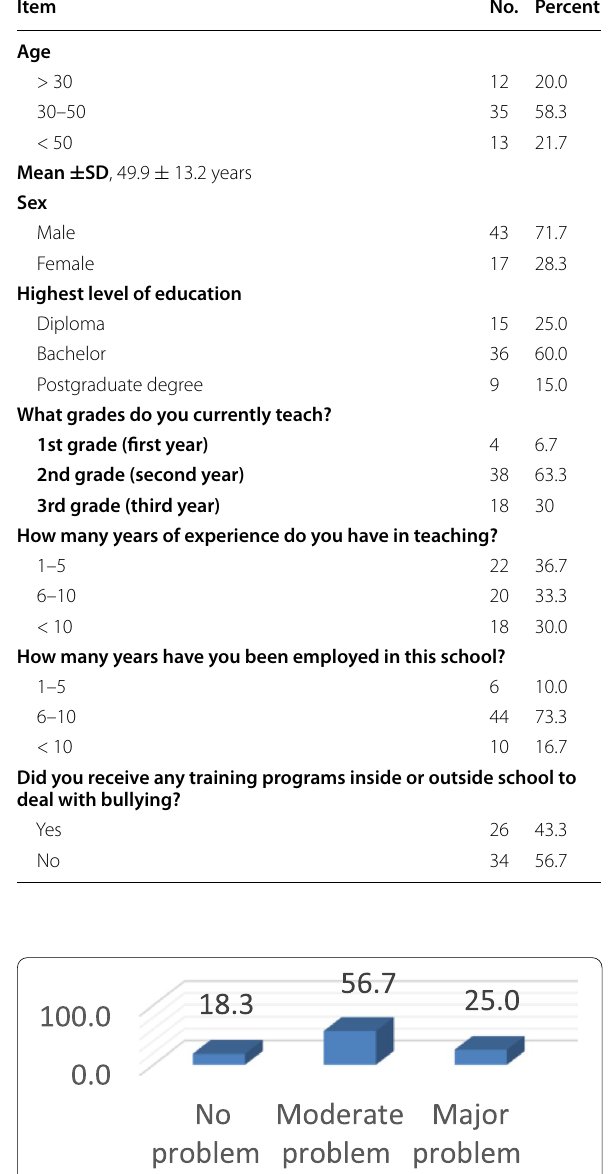
Fig. 1 Teachers’ opinion about bullying problems in their school (